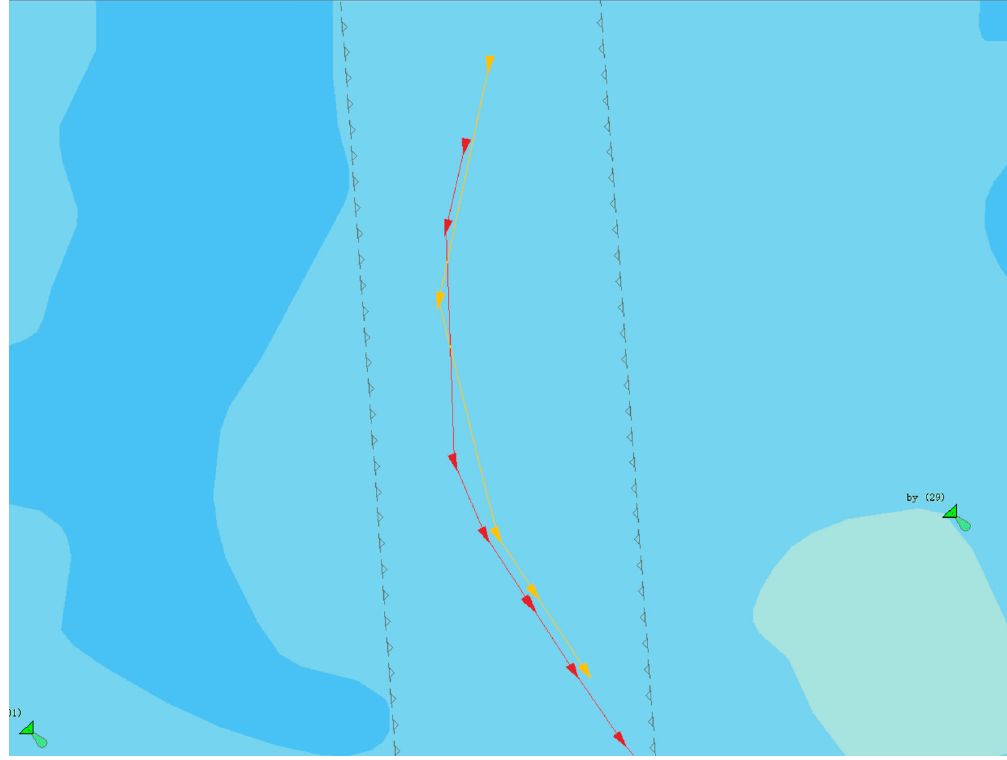
Figure 20. Schematic diagram of the unmanned surface vehicle (USV) collision-avoidance process (1). J. Mar. Sci. Eng. 2020 , 8 , x FOR PEER REVIEW